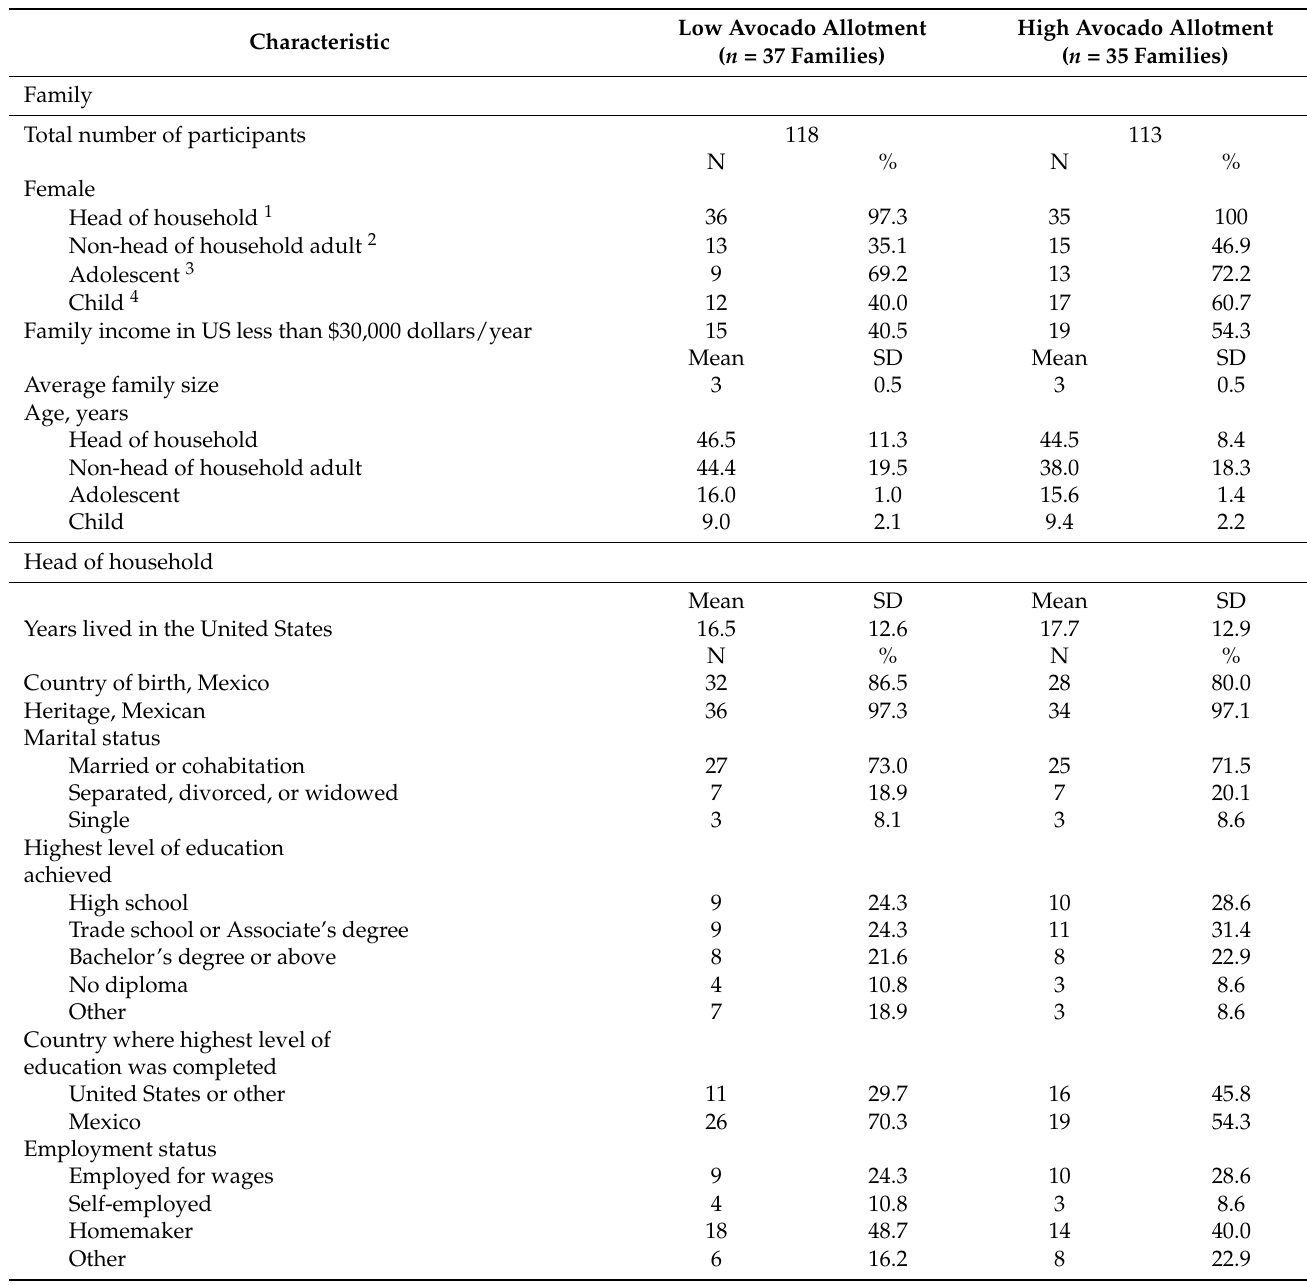
Table 1. Baseline demographic and dietary characteristics of randomized families participating in the Effects of Avocado Intake on the Nutritional Status of Families